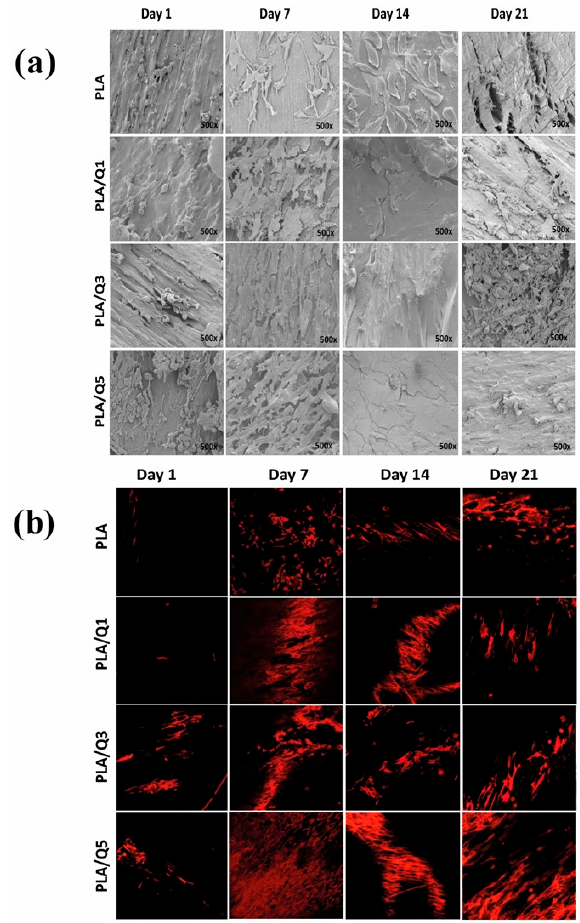
Figure 6. Adherence of MG-63 osteoblasts on PLA and PLA/chitosan composites after different incubation times. ( a ) SEM images taken at 500×; ( b ) Confocal microscopy images taken at 20×,